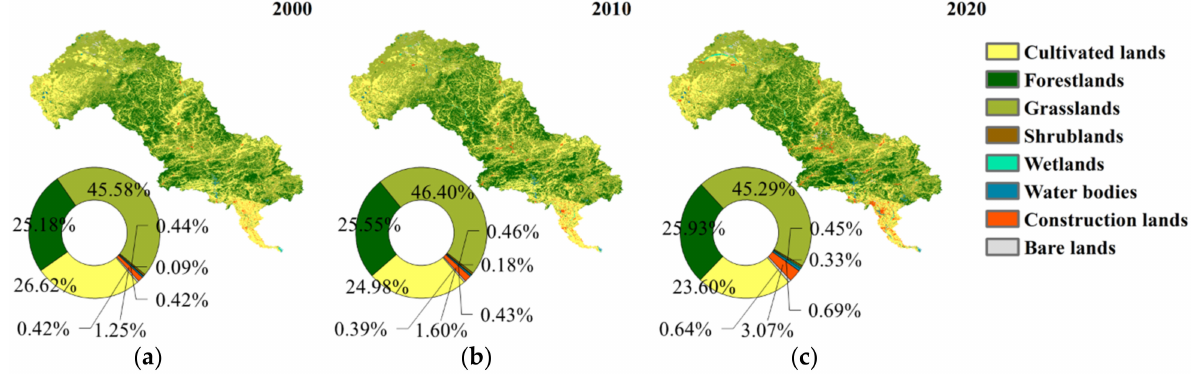
Figure 10. Land use in ( a ) 2000, ( b ) 2010, ( c )